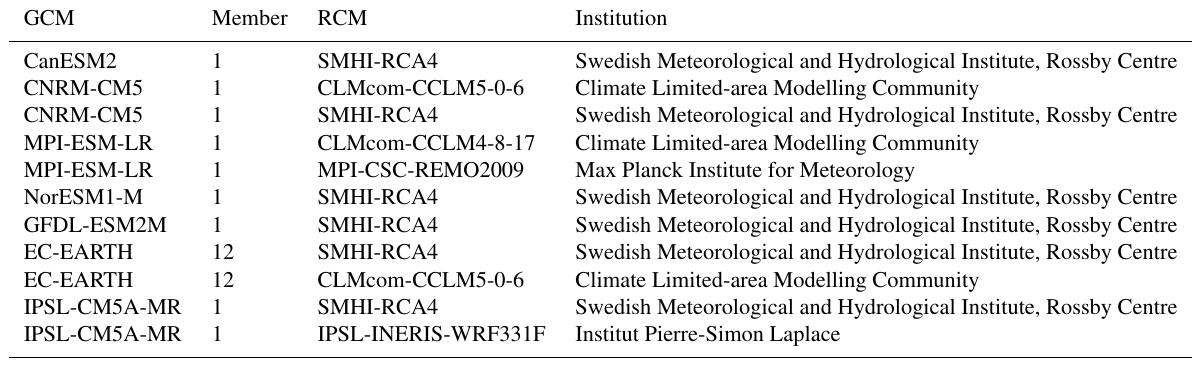
Table 2. Details of the EURO-CORDEX (EUR-44 domain) RCM simulations used in this study. The first two columns show the GCM and ensemble member driving the RCM.